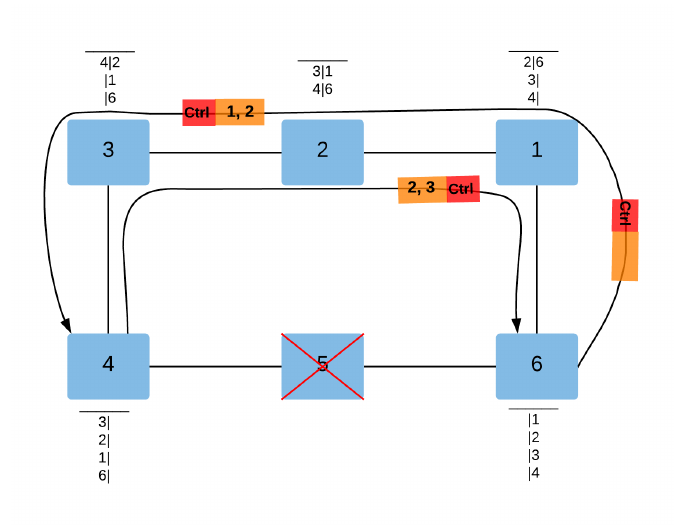
Figure 9. The QoS-ARRP Auto-configuration Mechanism after a failure